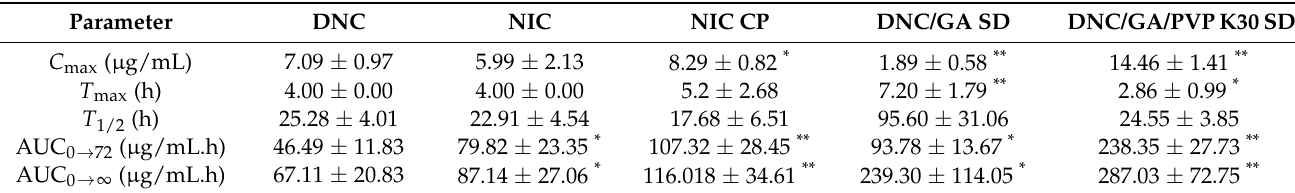
Figure 12. Concentration of DNC in plasma after oral administration. Table 4. Pharmacokinetic parameters of DNC by oral administration (n =